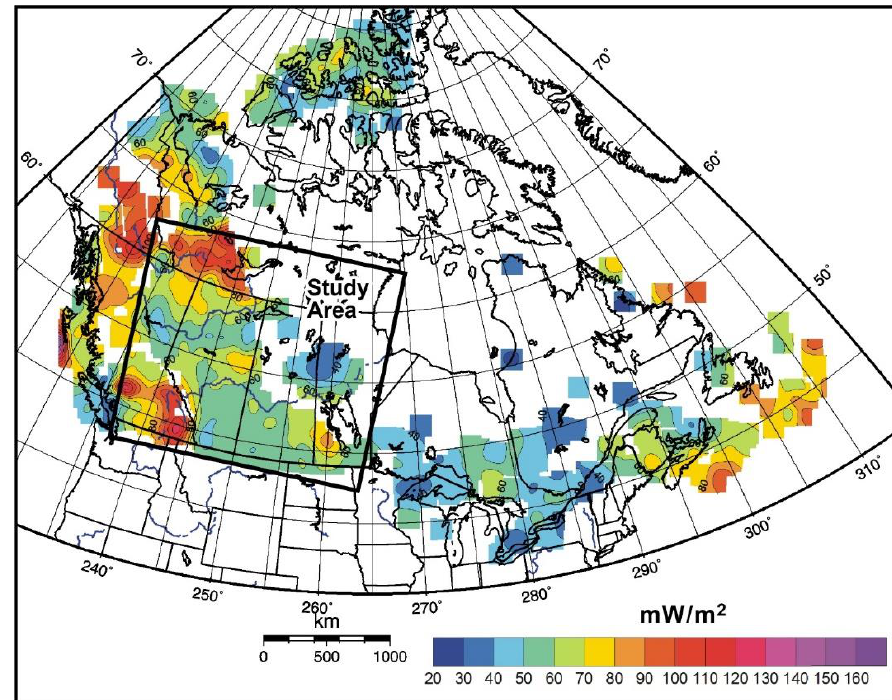
Figure 4. Study area against the map of heat flow Q of Canada (modified from [10]).